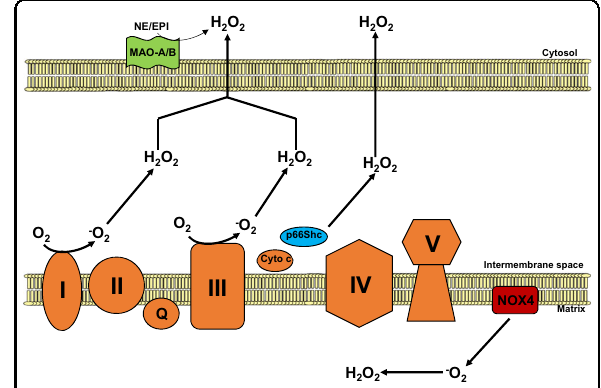
Fig. 1 Mitochondrial ROS generation. Respiratory chain complexes I and III (orange) generate superoxide (O 2 − ) and hydrogen peroxide (H 2 O 2 ) from molecular oxygen (O 2 ) within the mitochondrial intermembrane space. p66Shc (blue), in association with cytochrome c , participates in ROS signaling by producing hydrogen peroxide also within the intermembrane space. NADPH oxidase 4 (NOX4; red) localizes to the inner mitochondrial membrane, generating O 2 − and H 2 O 2 within the mitochondrial matrix. Monoamine oxidase isoforms A and B (MAO-A/B; green) degrade monoamines to aldehydes and H 2 O 2 in the outer mitochondrial